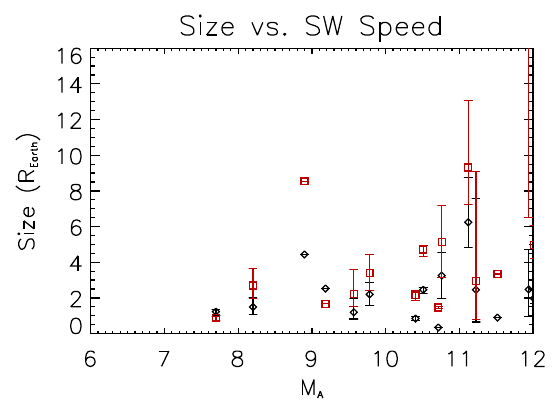
Fig. 8. The size-velocity functions with Alfv´en velocity calculated using ACE and crossing time measured by Cluster. The sizes were calculated using the method based on Alfv´en speed (black) and the transition speed (red). The fixed solar wind speed was measured in units of Alfv´en Mach number. γ = 80 ◦ ± 10 ◦ and 18 = 40 ◦ ± 20 ◦ . All Alfv´en Mach numbers were calculated from the actual Alfv´en